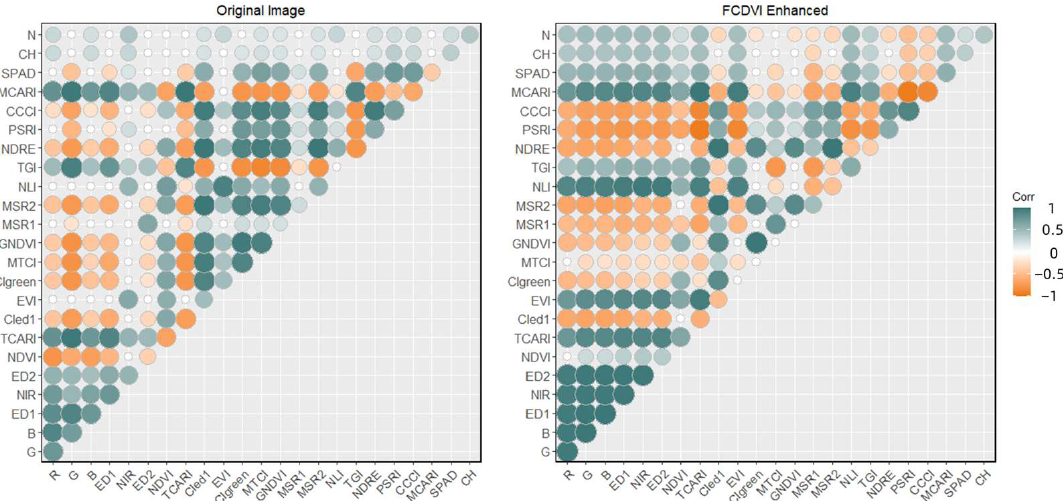
Figure 9. Correlation between vegetation index and tea physiological parameters calculated from multispectral images before and after full channel difference vegetation index enhancement. The blank sections indicate failed significance tests. NDVI, normalised difference vegetation index; NDRE, normalised difference red edge; CIed1, chlorophyll index red edge; MTCI, MERIS terrestrial chlorophyll index; MCARI, modified chlorophyll absorption ratio index; EVI, enhanced vegetation index; TCARI, transformed CARI; MSR1, modified simple ratio 1; MSR2, modified simple ratio 2; CIgreen, chlorophyll index green; GNDVI, green normalised difference vegetation index; PSRI, plant senescence reflectance index; CCCI, canopy chlorophyll content index; NLI, nonlinear vegetation index; TGI, triangular greenness index; SPAD, value measured using the spad-502 plus instrument; CH, total chlorophyll content; and N, total nitrogen content.